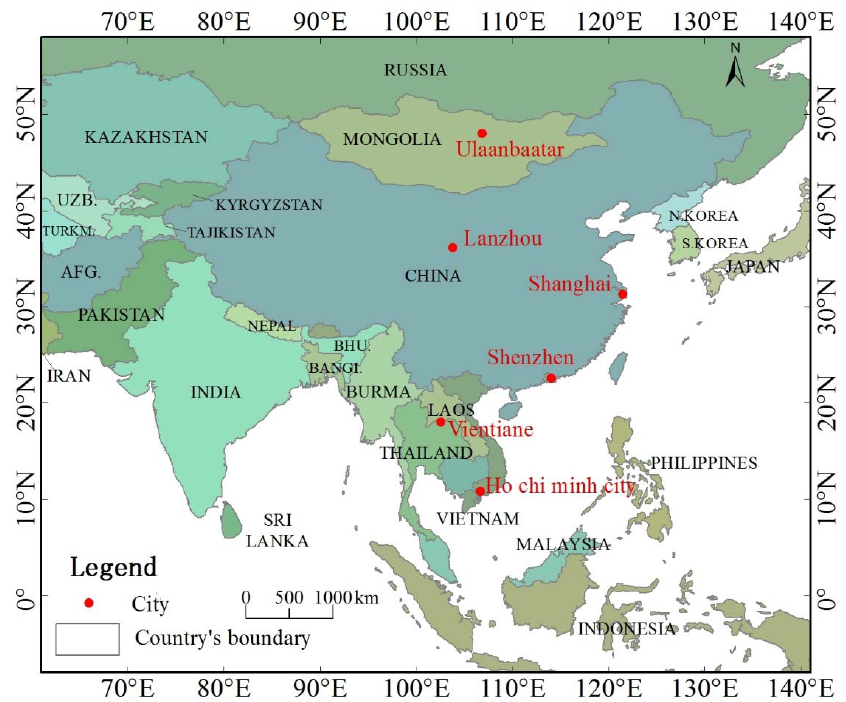
Figure 1. Locations of the six metropoles selected for study, three coastal (Shanghai and Shenzhen in China, and Ho Chi Minh City in Vietnam) and three inland (Ulaanbaatar in Mongolia, Lanzhou in China, and Vientiane in Laos).